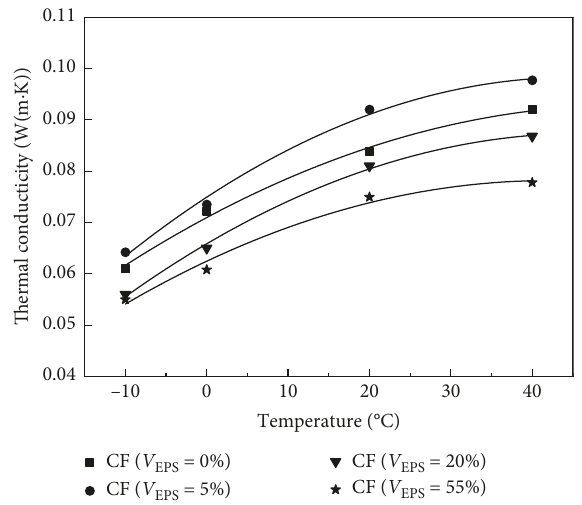
Figure 5: Thermal conductivity of different EPS volume fraction FC with temperature.